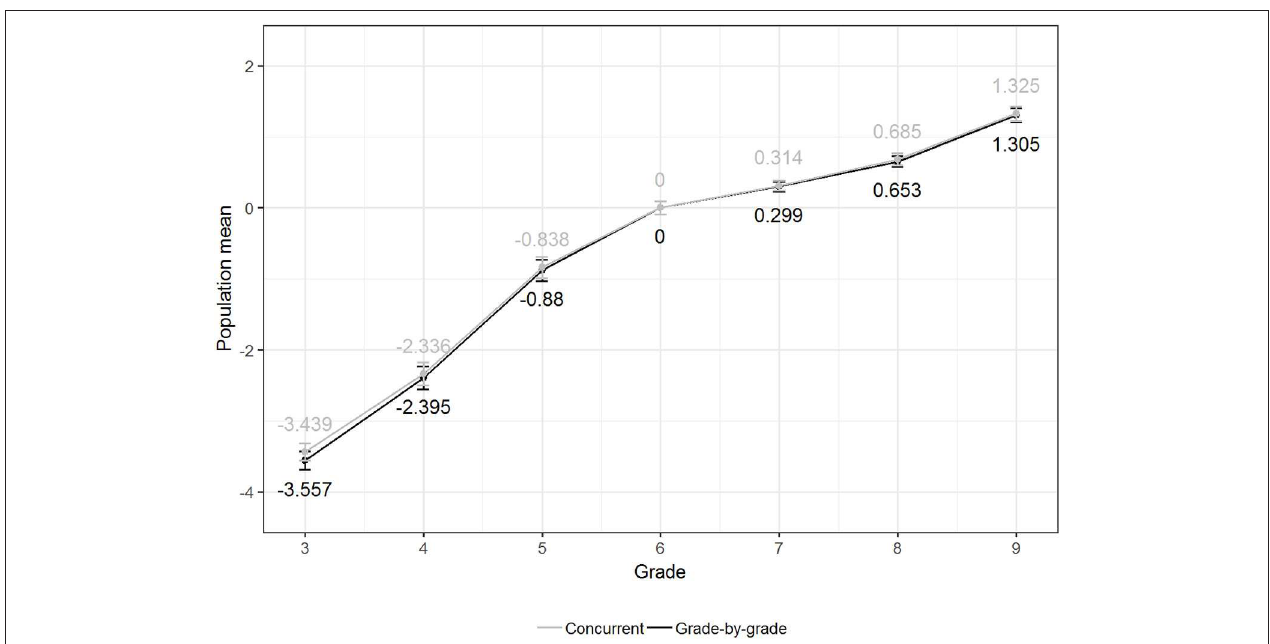
FIGURE 2 | Estimated population means based on the final calibration run for the concurrent and grade-by-grade calibrations, including the 95% confidence interval.